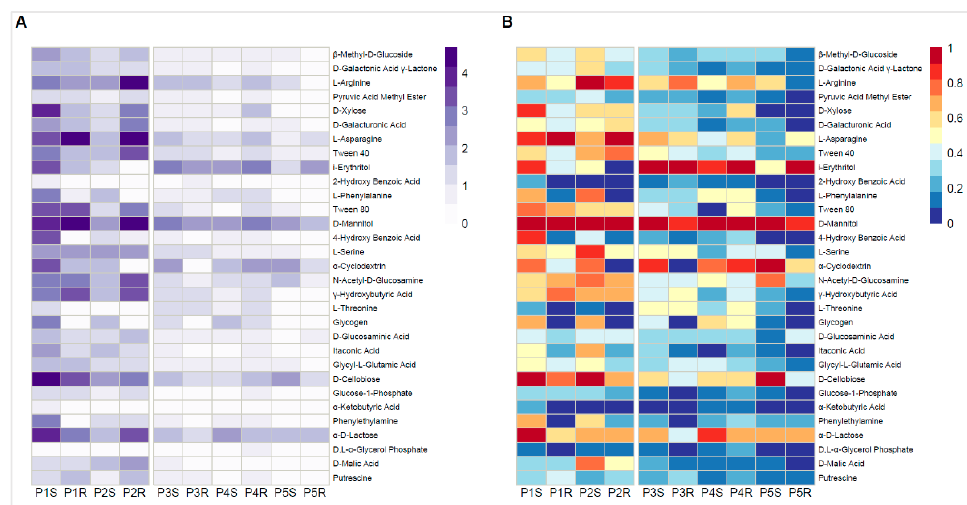
Figure 4. Heatmap displaying Poa annua rhizosphere and root community responses on Biolog Ecoplates. ( A )—mean absorbance values from three replicates; color scale—absorbance values at 590 nm, ( B )—scaling within a particular carbon source across all examined samples; absorbance above average—red, absorbance below average—blue. S—rhizospheric soil samples, R—root samples, P1–P2—Central European (Poland) samples, P3–P5—Antarctic samples (King George Island).